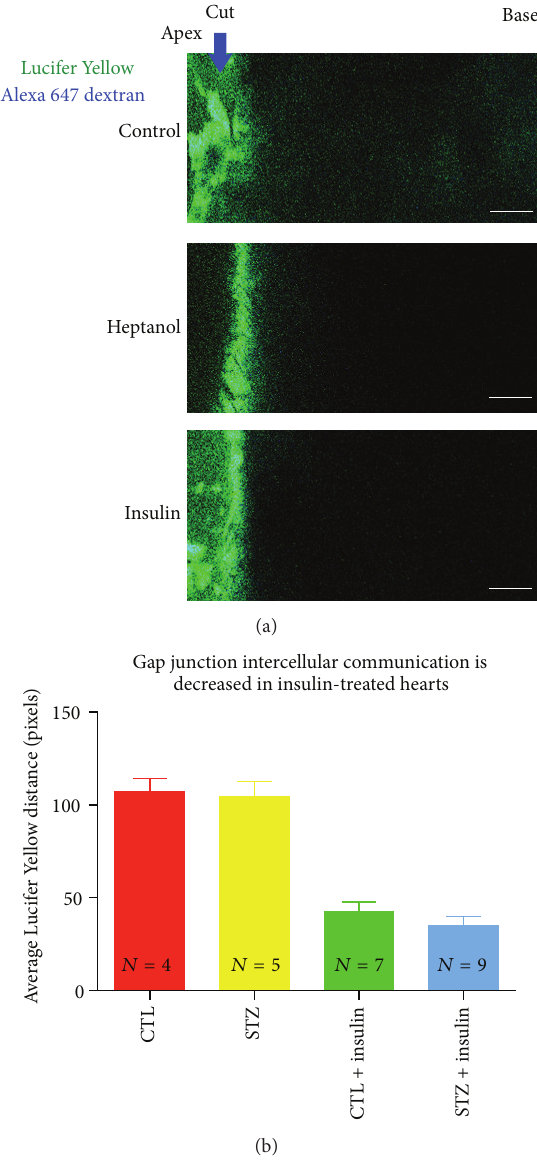
Figure 3: Lucifer Yellow dye spread is decreased in insulin-treated hearts. Representative images of Lucifer Yellow dye propagation through the ventricle of control animals and those treated with heptanol and insulin (a). The propagation of Lucifer Yellow is substantially decreased in hearts treated with insulin independent of STZ treatment (b), 𝑝 < 0.05 . Scale bar = 100 𝜇 M. Multiple comparisons performed using Kruskal-Wallis test, 𝑝 = 0.0007 , applying Dunn’s post hoc testing; CTL versus STZ = ns, CTL versus CTL + insulin, and STZ versus STZ + insulin were significantly